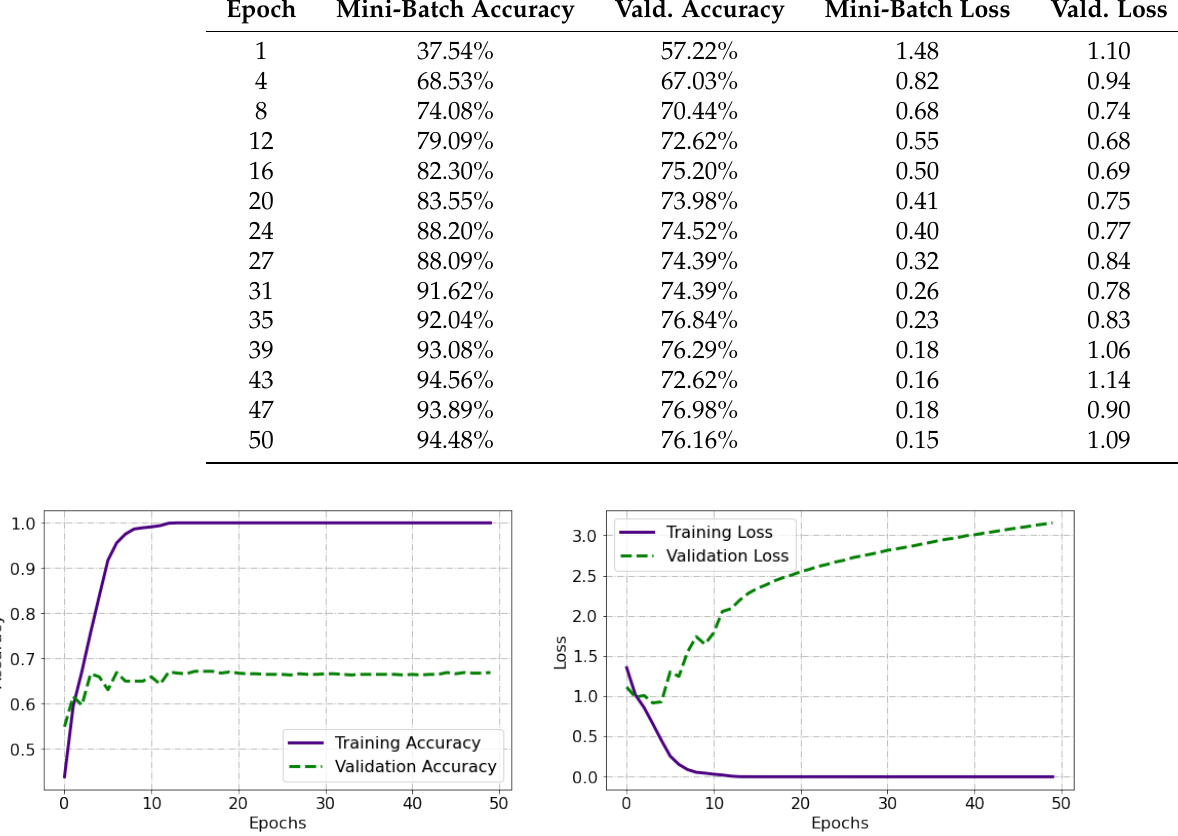
Figure 10. Model performance without data